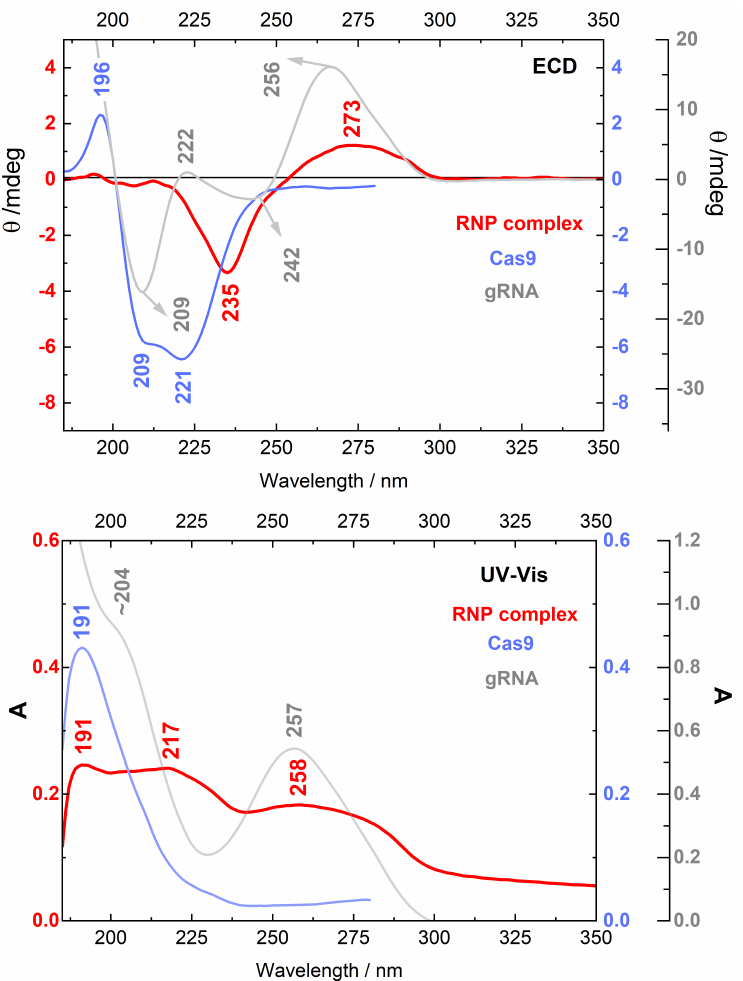
Figure 4. ECD and UV-Vis spectra of the Cas9:gRNA complex (red line and left scale; in the 1:1 molar ratio with individual concentrations C CAS9 = 9.98 × 10 − 6 M and C gRNA = 1.07 × 10 − 5 M) in compar- ison to the spectra of the Cas9 protein (light blue line and the 1st right scale, C = 9.35 × 10 − 7 M) and gRNA (light gray line and the 2nd right scale C = 1.07 × 10 − 5 M). ECD: electronic circular